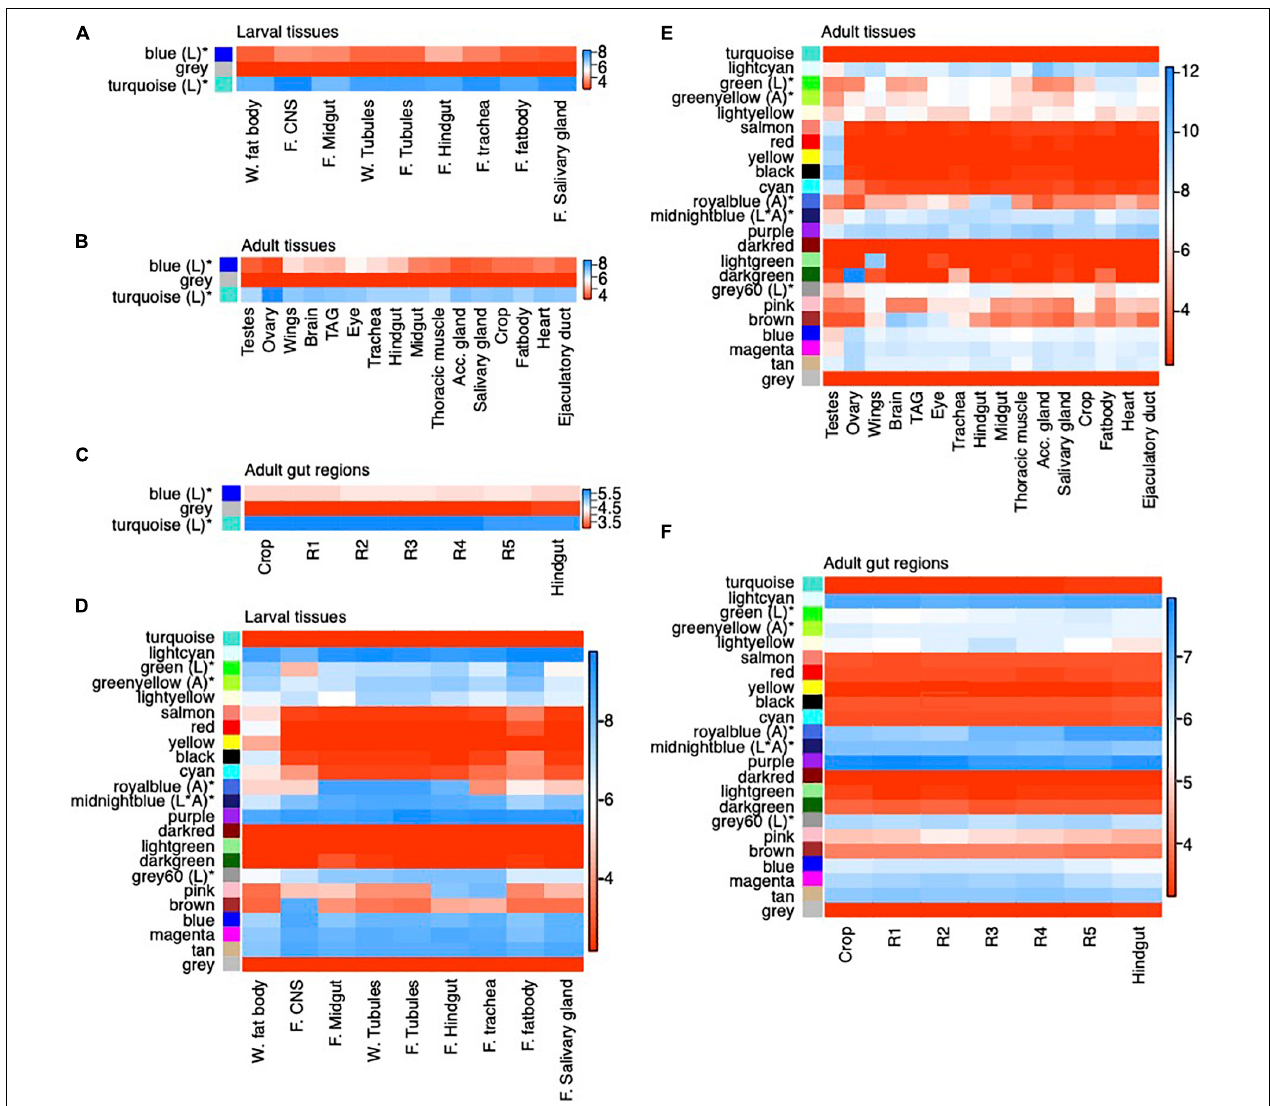
FIGURE 3 | Heatmaps of module median expression in the FlyAtlas and FlyGut tissue-specific gene expression databases. Median expression of female modules per tissue in (A) larval tissues in FlyAtlas, (B) adult tissues in FlyAtlas and (C) across gut regions in FlyGut. Median expression of male modules per tissue in (D) larval tissues in FlyAtlas, (E) adult tissues in FlyAtlas, and (F) across gut regions in FlyGut. W: wandering, F: feeding, CNS: central nervous system, Acc. gland: accessory gland. For larval tissues “W.” refers to tissues collected during the wandering larval stage (late third instar) and “F.” refers to tissues collected while third instar larvae were still feeding. For FlyGut data (C,F) R1 through R5 refer to five sequential regions of the gut which are delineated by the combination of an anatomical constriction between one region and the next, changes in histology and changes in gene expression (Buchon et al., 2013). Modules are shown in the same order as they appear in the hierarchical clustering dendrogram. Modules whose expression is affected by larval or adult diet are indicated by a “*” and annotated with whether they are affected by larval diet (L), adult diet (A), or their interaction